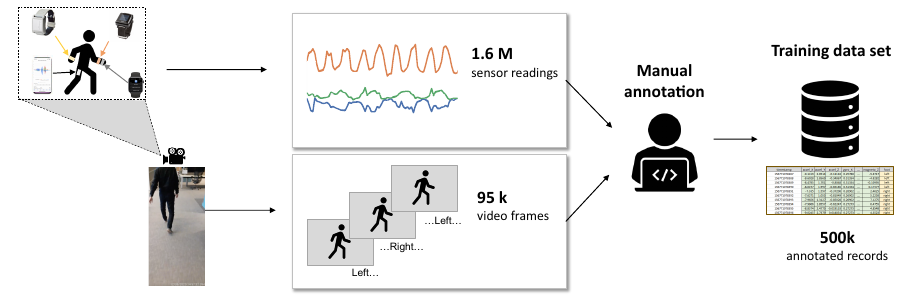
Figure 1. Overall workflow to generate the AZ